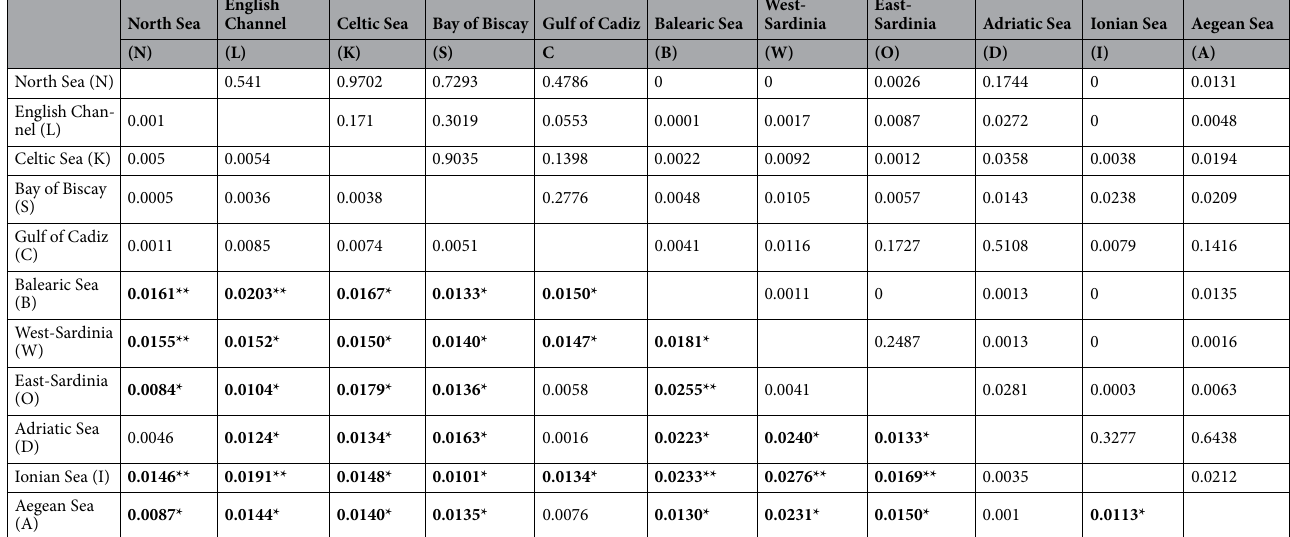
Table 2. F ST values (below diagonal) and p -values (above diagonal) of pairwise comparison of the sampled areas regarding microsatellites; significant differentiations highlighted in bold: p = 0.05*; p = 0.0009**